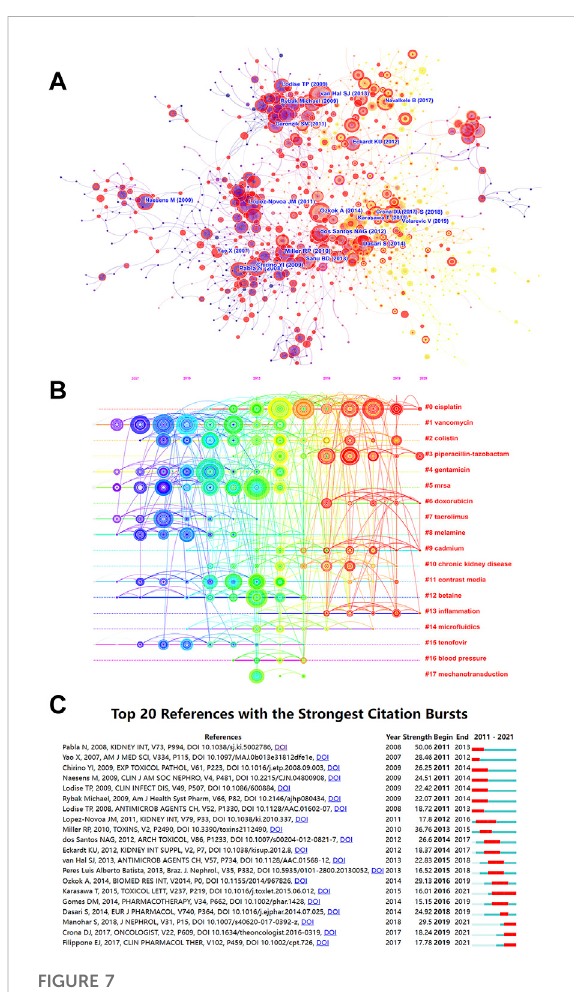
FIGURE 7 Analysis of most commonly cited references related to nephrotoxicityresearch. (A) Co-citationnetwork ofreferences. (B) Timeline view of reference cluster analysis. (C) Top 20 references with the strongest citation